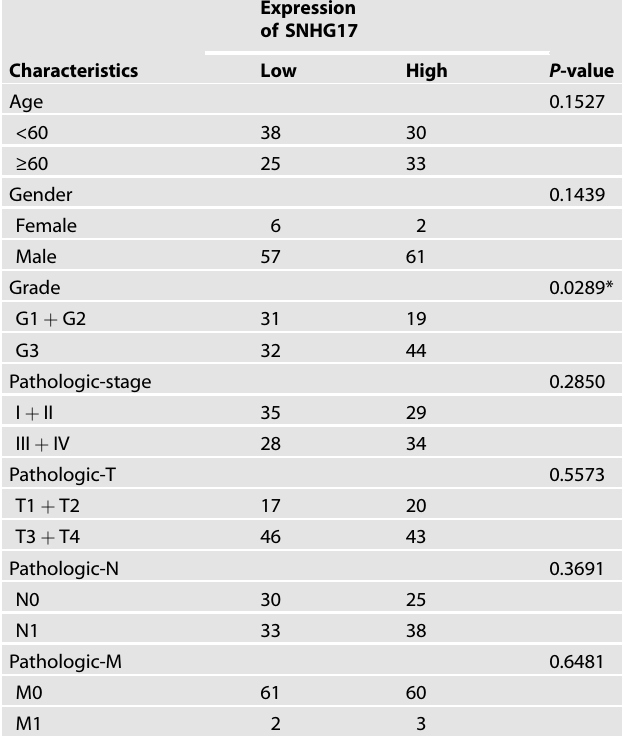
Table 1. Correlations between SNHG17 expression and clinicopathologic features of ESCC patients. Expression of